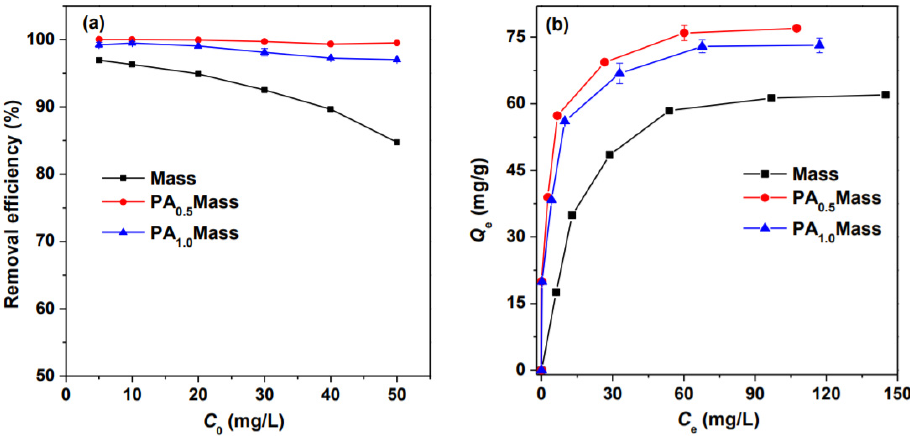
Figure 1. ( a ) Removal of Pb and ( b ) sorption isotherms (at 25 ◦ C) of Pb by the Hydrocotyle biomass (Mass) and the biomass samples after PA pretreatment (PA 0.5 Mass and PA 1.0 Mass).